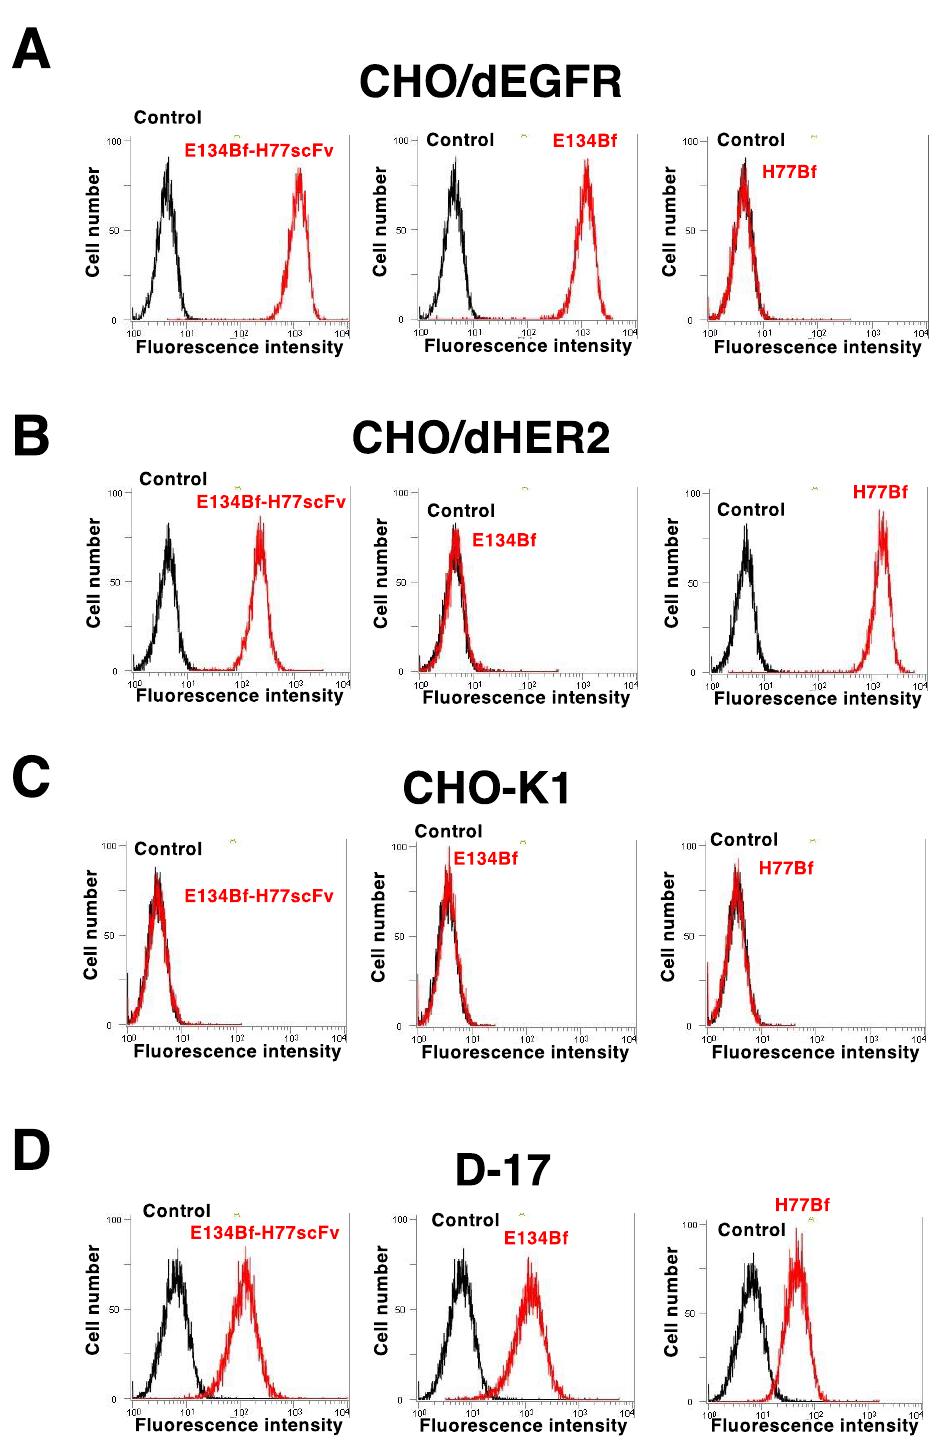
Figure 2. Flow cytometry using E134Bf, H77Bf, and E134Bf-H77scFv. CHO/dEGFR ( A ), CHO/dHER2 ( B ), CHO-K1 ( C ), and D-17 ( D ) cells were treated with 1 µ g/mL of E134Bf, H77Bf, and E134Bf-H77scFv or buffer control, followed by Alexa Fluor 488-conjugated anti-dog IgG. Fluorescence data were analyzed using the Cell Analyzer EC800.